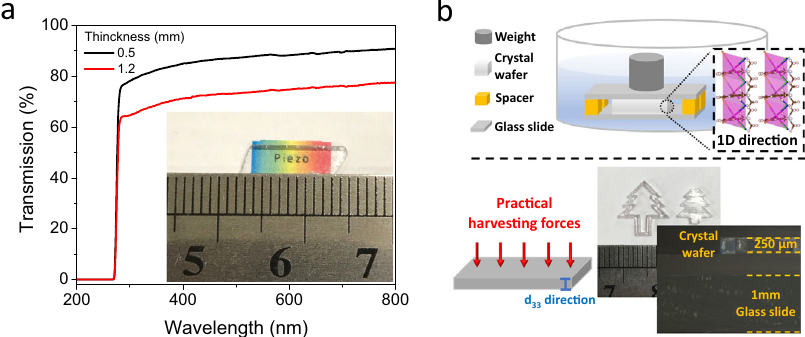
Fig. 5 | Optical transmission and crystal wafer synthesis. a Optical transmission spectraof x =0.25singlecrystalswithtwothicknesses.Inset:photoofcrystalwitha ‘ piezo ’ background. b Synthesis setup of crystal wafer with d